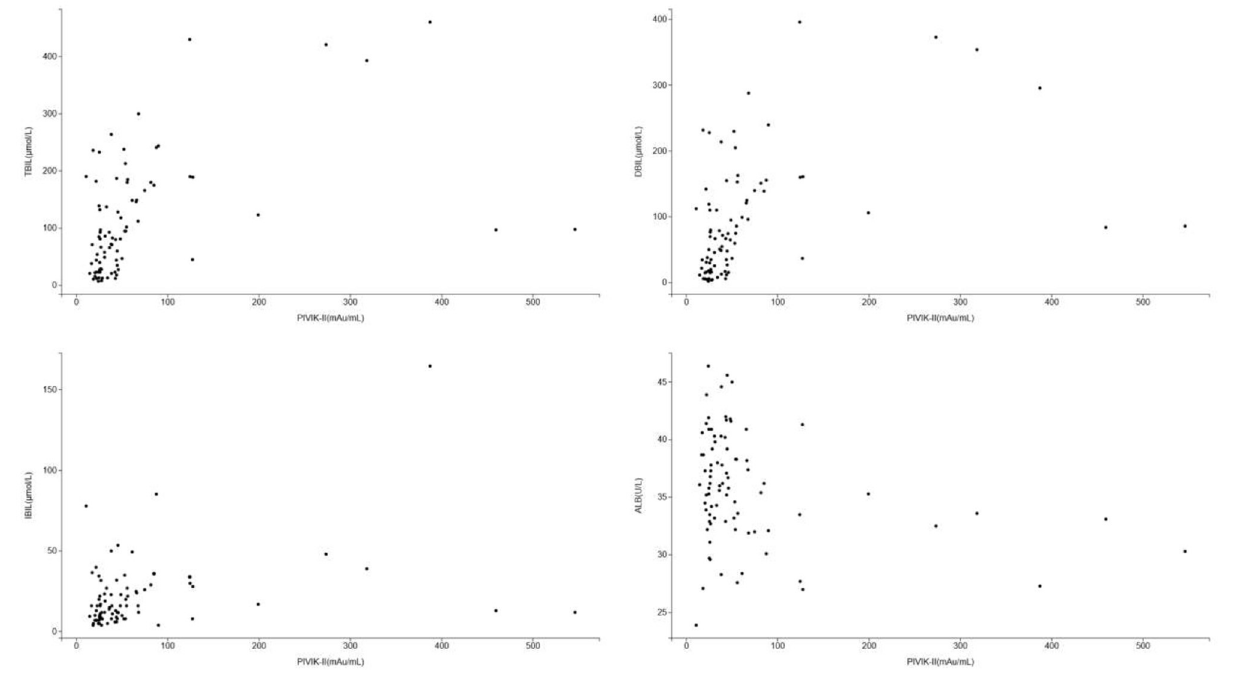
rate of more than 10% (15, 16). In our current study,